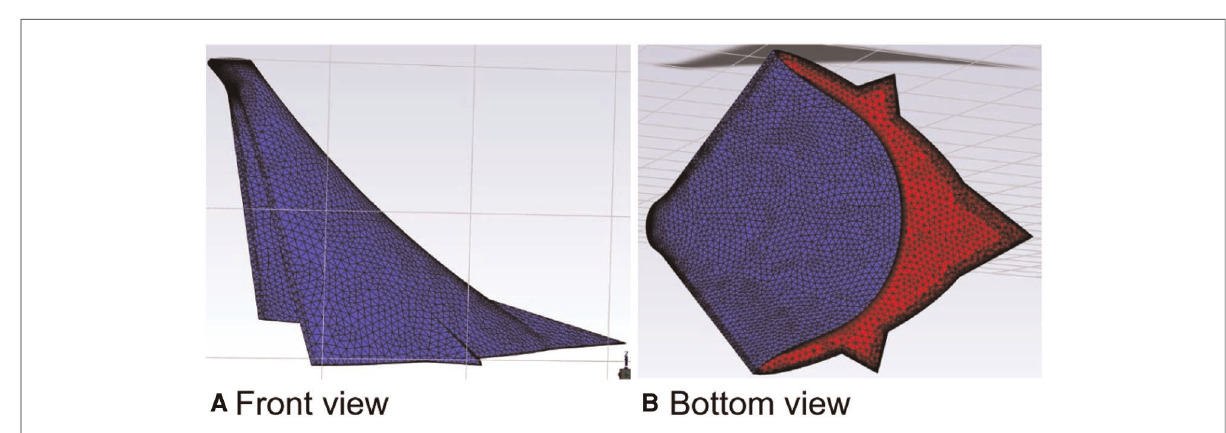
FIGURE 14 Curved model of the curved plus extended groove incision.